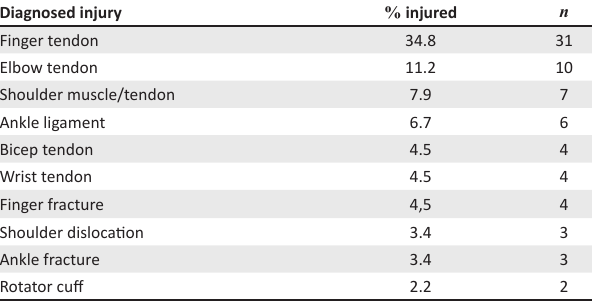
TABLE 2: Most common self-reported